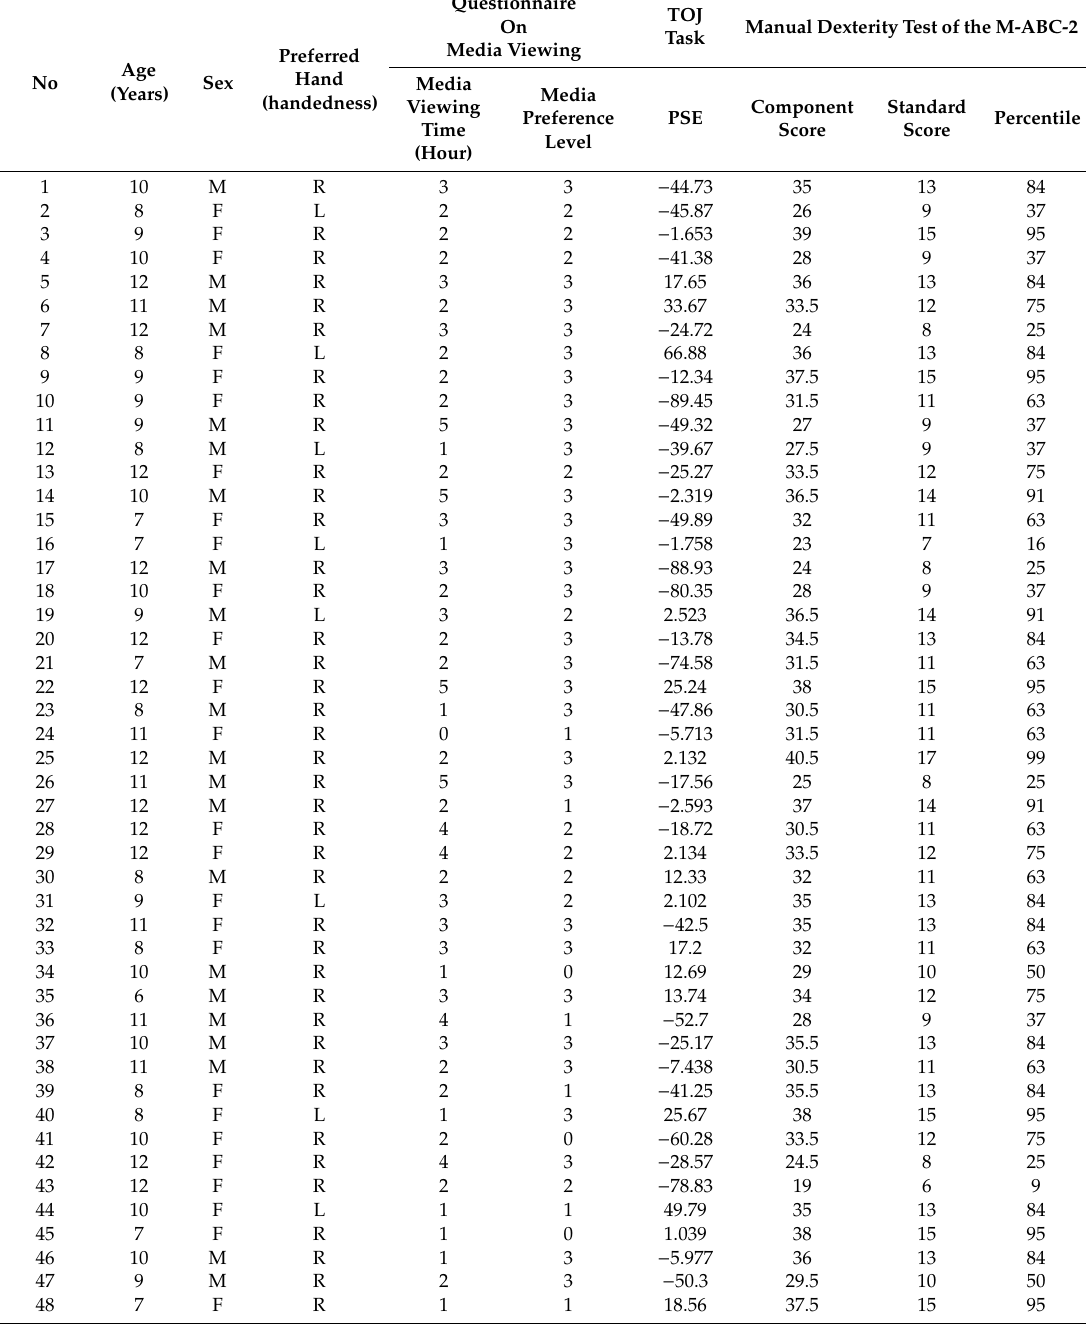
Table A1. Raw data for the entire